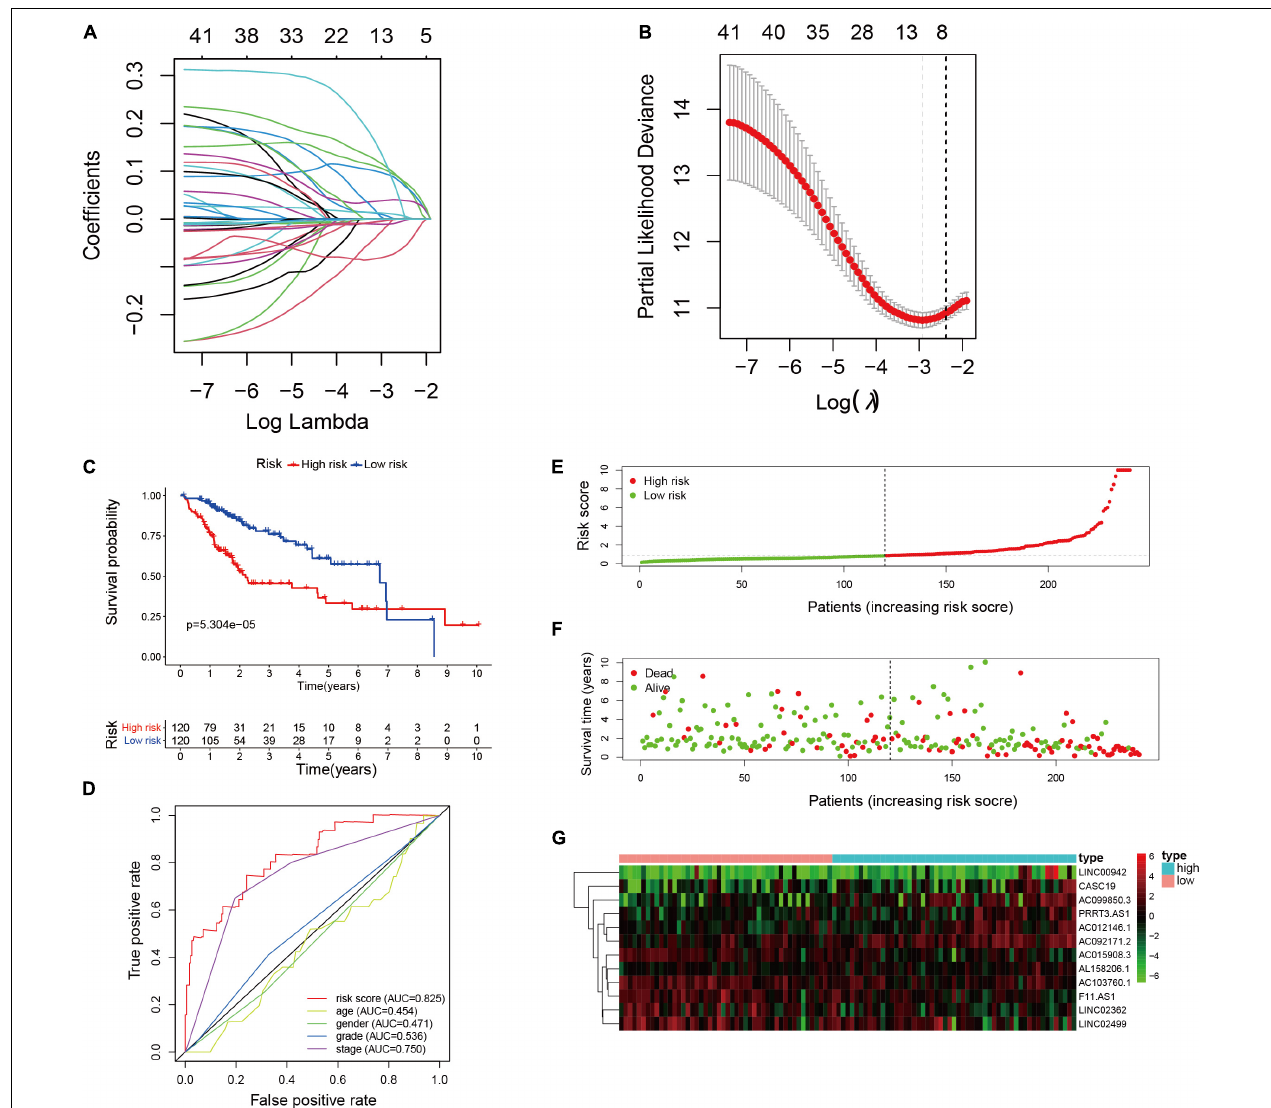
FIGURE 2 | Construction of the EMT-related lncRNAs risk signature in training cohort. (A) LASSO coefficient profiles of the EMT-related lncRNAs. (B) Cross validation for tuning parameter selection in the proportional hazards model. (C) Kaplan-Meier survival analysis of the high- and low-risk groups. (D) The precision of the prognostic model was evaluated with Multi-indicator receiver operating characteristic (ROC) curves. (E) Risk score curves based on the risk score of each patient. (F) Scatter plots based on the survival status of each patient. (G) Heatmap displaying the expression levels of the 12 EMT-related lncRNAs in high- and low-risk